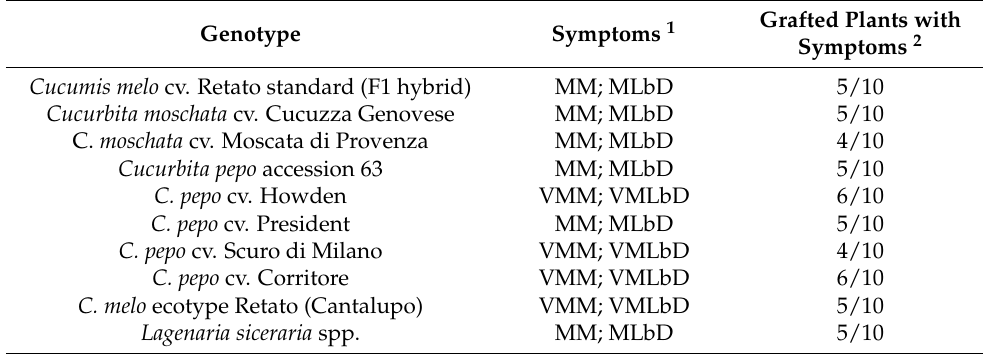
Table 2. Averages of symptoms induced by ToLCNDV-Le infection on the scion of different plants grafted onto C. melo cv. Barattiere at 28 dpi.